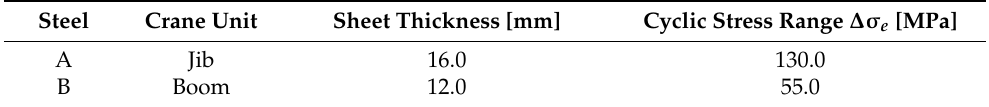
Table 1. Cyclic stress ranges at the surface of considered crane